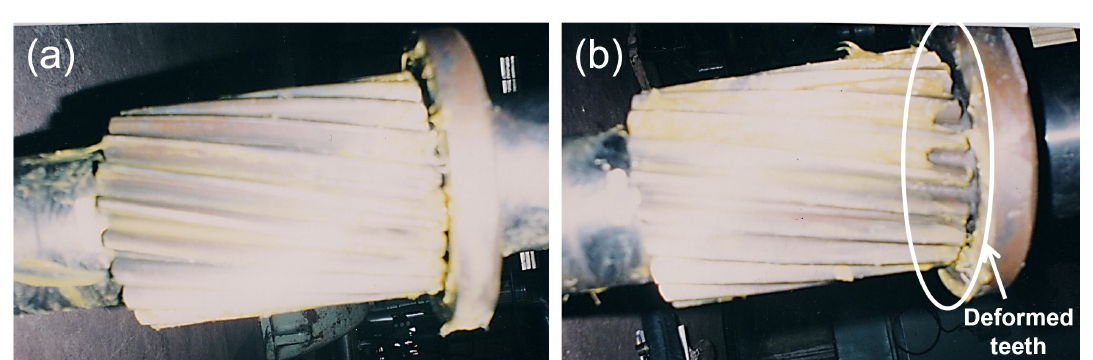
Figure 3. ( a ) Healthy pinion teeth (without deformation) when operated at 3 MW; ( b ) deformed teeth of pinion near thrust disc when operated at 3.75